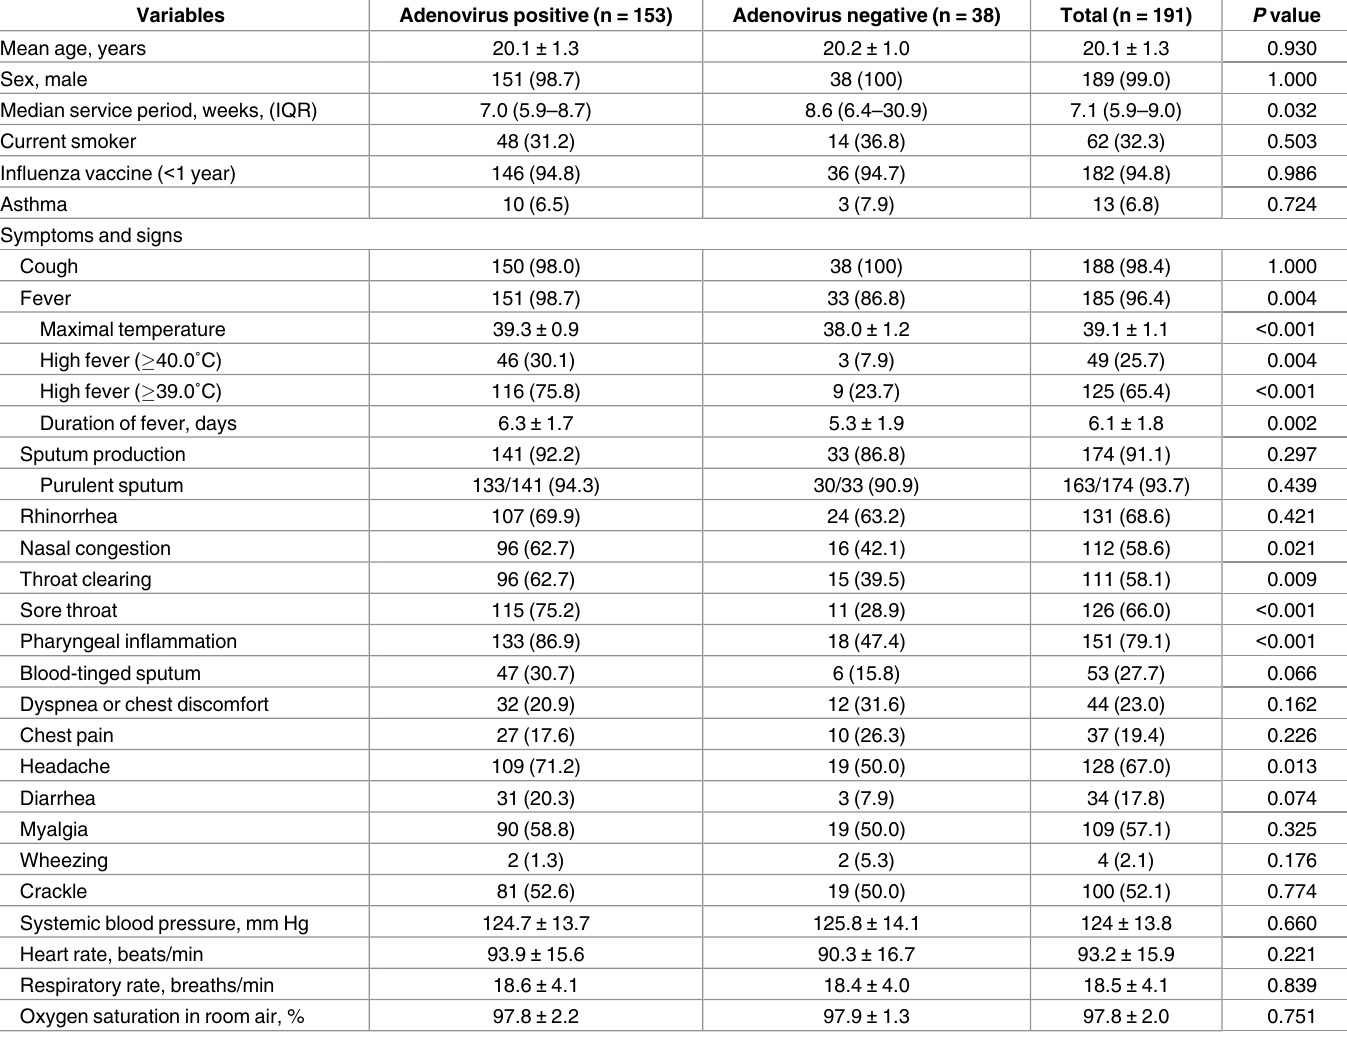
Table 1. Clinical characteristics of 191 patients with community-acquired pneumonia in the